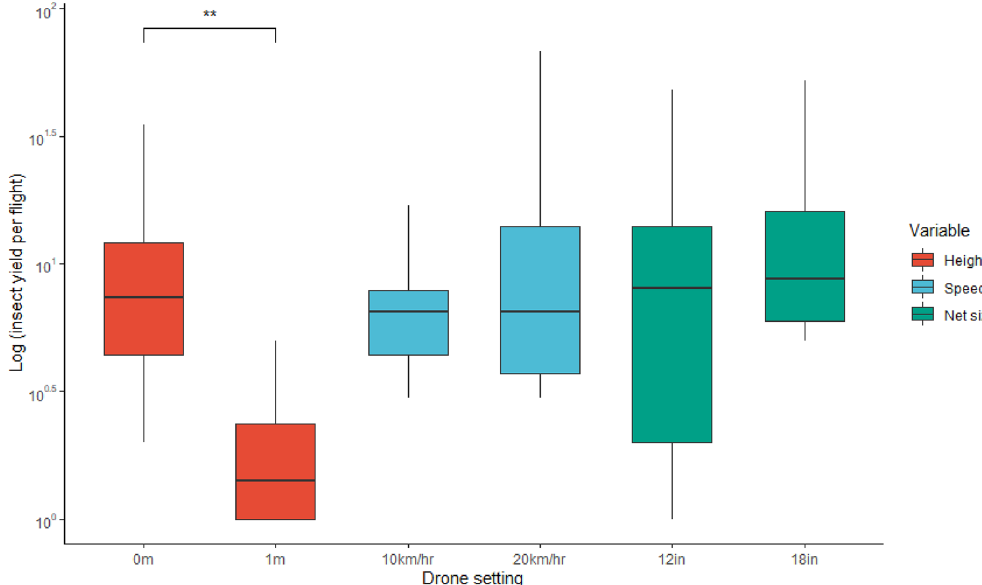
Figure 2. Boxplot of arthropod yields for different drone settings of height, speed, and net size (diameter). Boxes indicate median, first and third quartile, as well as minimum and maximum values. Significance stars are place based on paired t-tests of settings values, ** denotes p < 0.01 (only differences in height were significant with p = 0.0017).